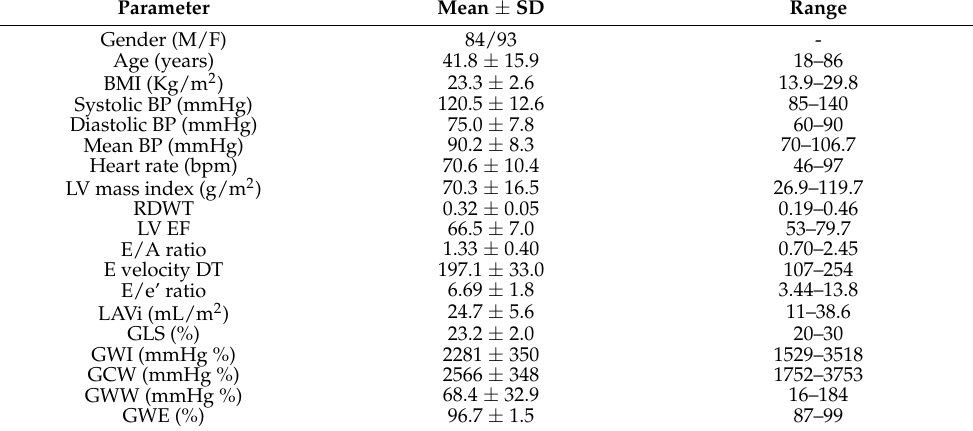
Table 1. Demographic and echo-Doppler characteristics of the study